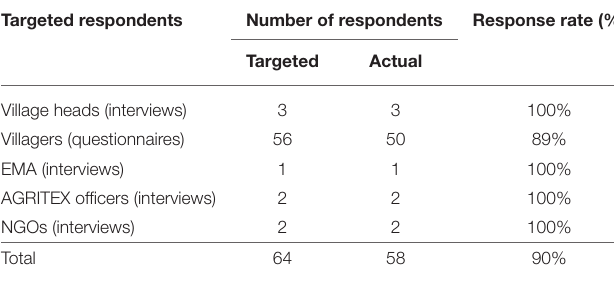
TABLE 1 | Distribution of